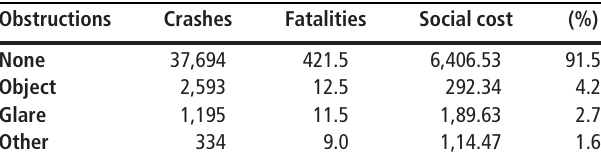
Figure 13 Speed distributions for the bicyclist ride through crossing the